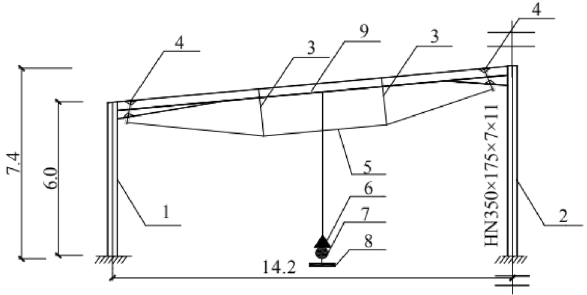
Fig. 17 Installation diagram: 1. Side column, 2. Middle column, 3. Strut, 4. I-shaped end anchor joint, 5. Steel strand, 6. Heavy ham- mer, 7. Dialgage, 8. Magnetic table seat, 9. Steel beam